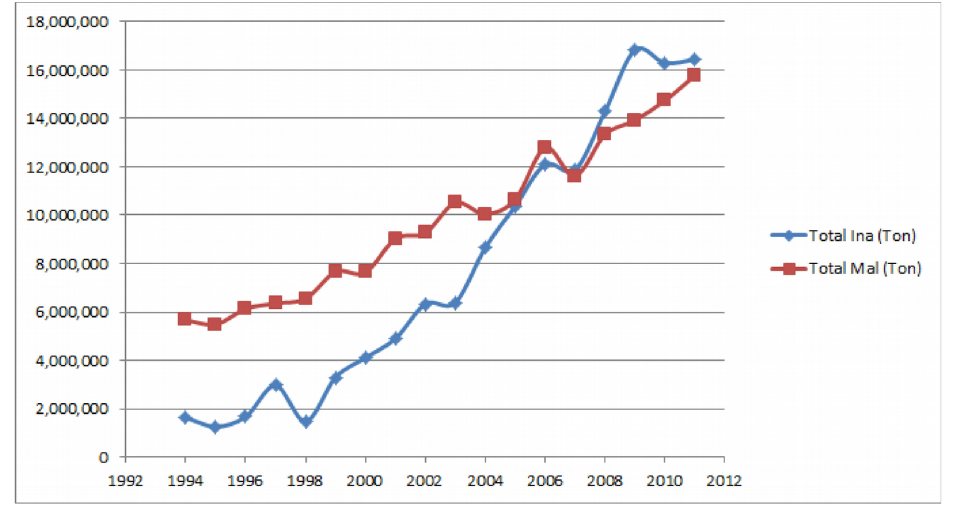
Figure 1. Palm Oil Export: Indonesia and Malaysia (UN Comtrade Database,